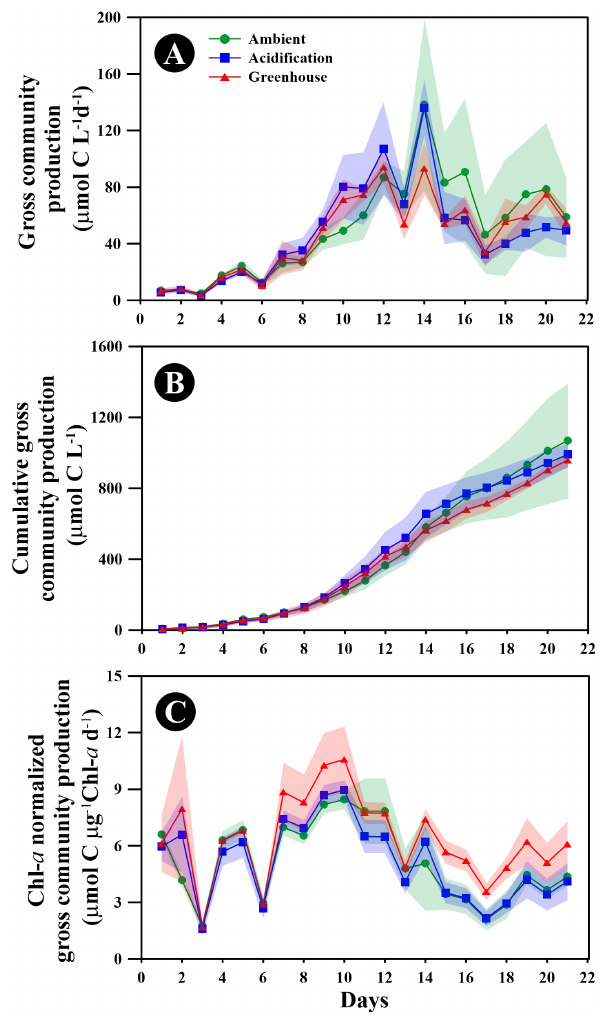
Fig. 4. Gross community production (GCP) (A) , cumulative GCP (B) , and Chl a normalized GCP (C) based on photosynthetic pa- rameters, in situ irradiance profiles, and Chl a concentration during the experimental period in the ambient (green), acidification (blue), and greenhouse (red) treatment conditions. Colored shading repre- sents the standard deviation from the mean (colored symbols and lines) of replicate enclosures ( n =